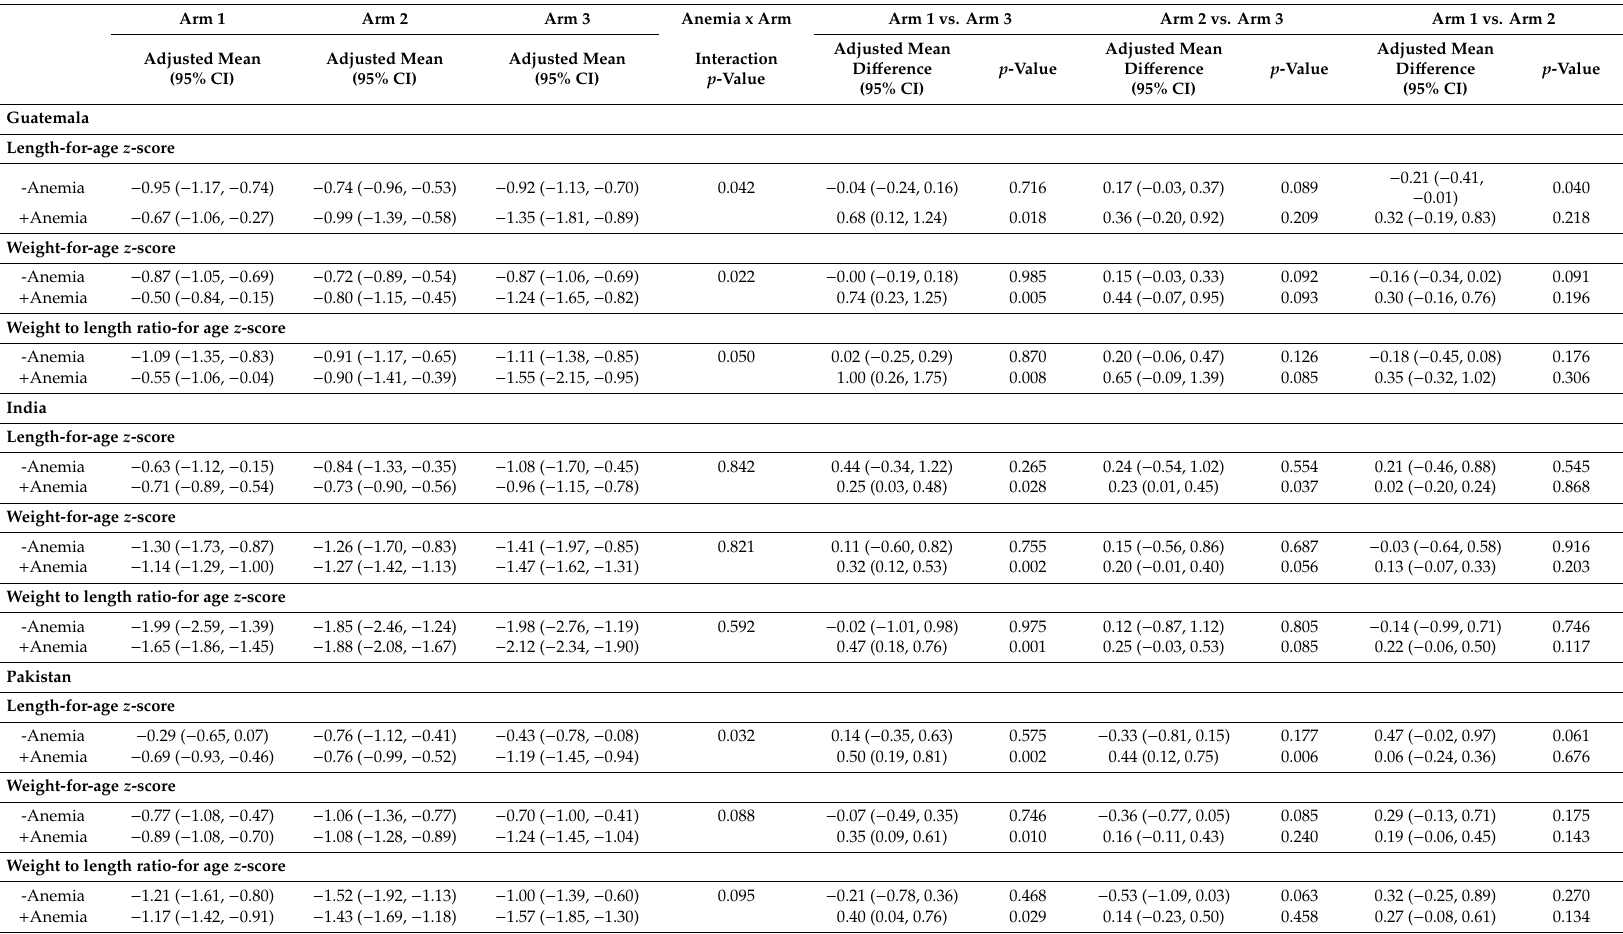
Table 6. Regression results of neonatal anthropometry by anemia: individual site